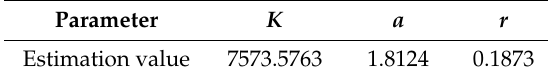
Table 3. Parameter estimation result of Logistic model.